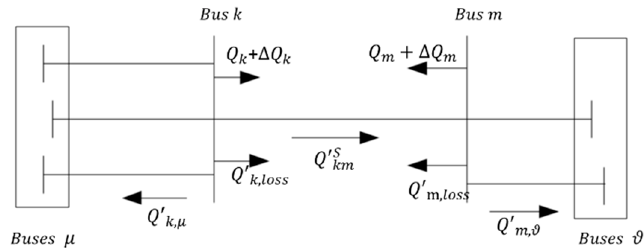
Figure 6. Simulated state of the power system.